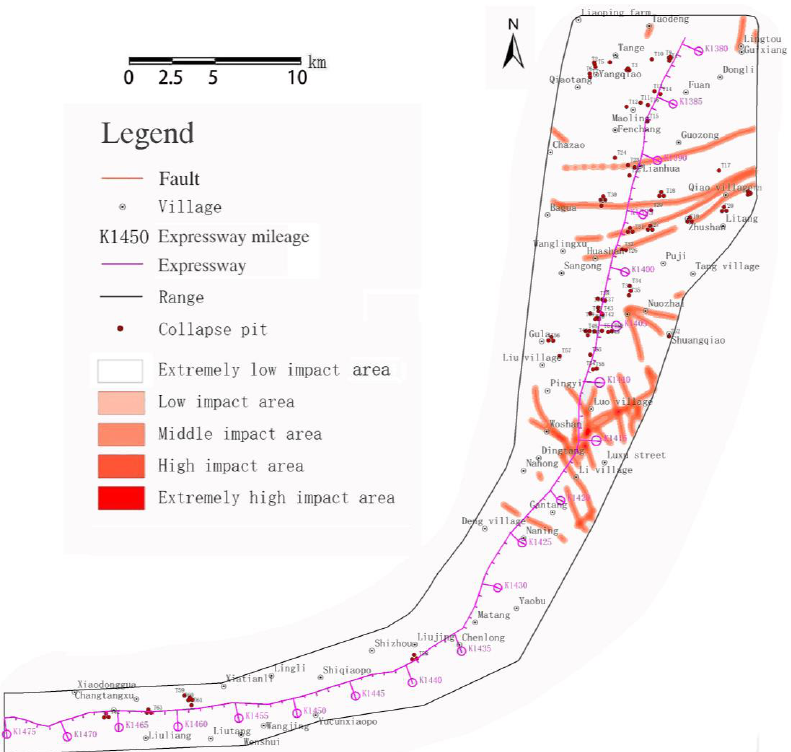
Water 2022 , 14 , x FOR PEER REVIEW Figure 10. Zoning map of influence degree of fault on karst collapse. Figure 10. Zoning map of influence degree of fault on karst collapse.